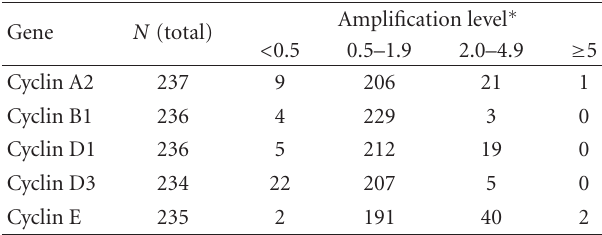
Table 6: Amplification of cyclin genes of the rectal